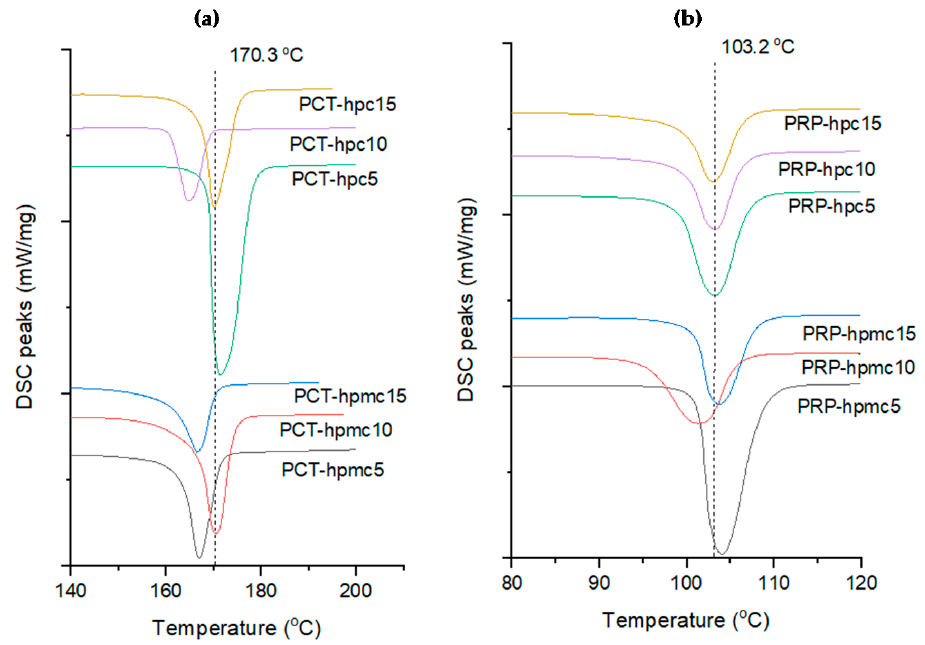
Figure 4. DSC thermograms of ( a ) co-spray dried paracetamol (PCT), and ( b ) co-spray dried propyphenazone (PRP) alone with the two studied polymers (dotted lines correspond to melting points of pure drugs).